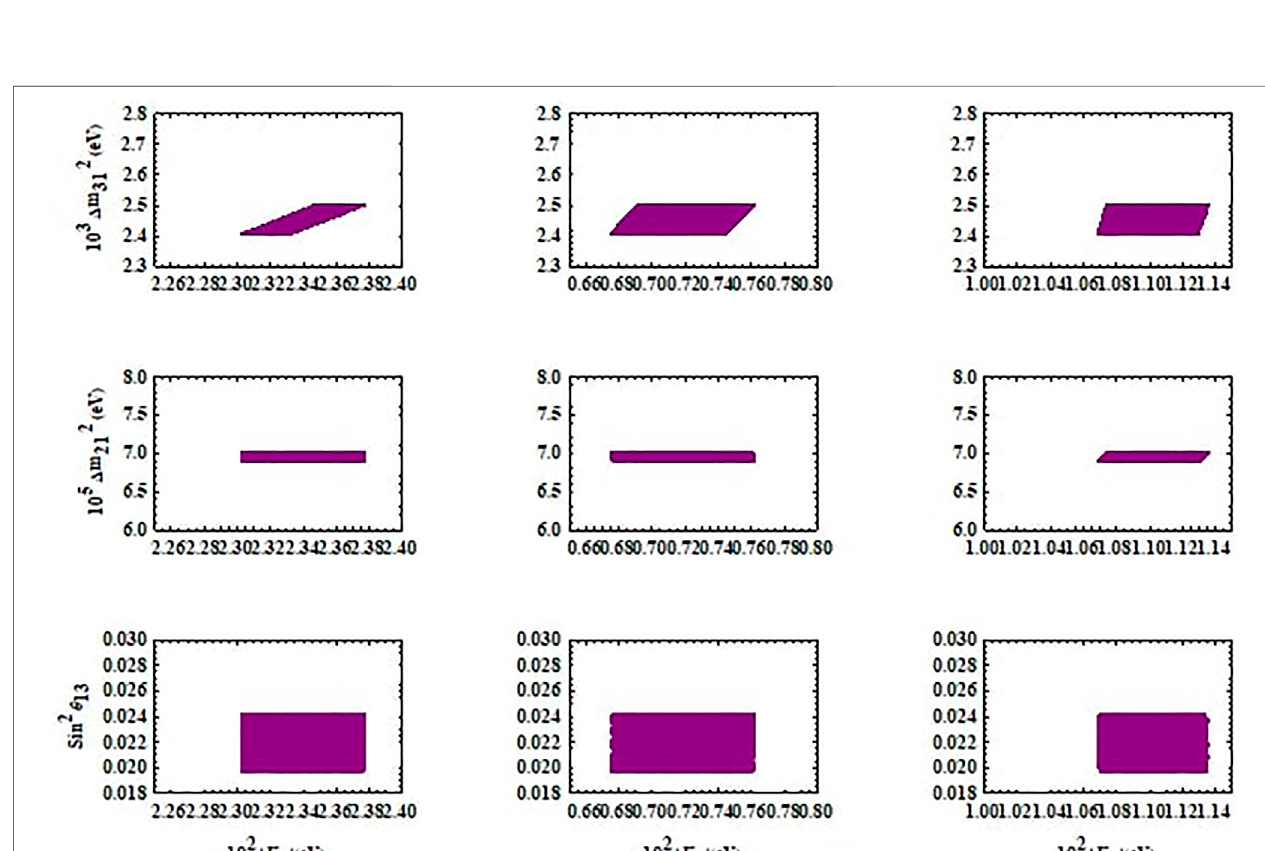
FIGURE 2 | The allowed region of Δ m 2 31 , Δ m 2 21 and mixing angle sin 2 θ 13 as a function of model parameters.